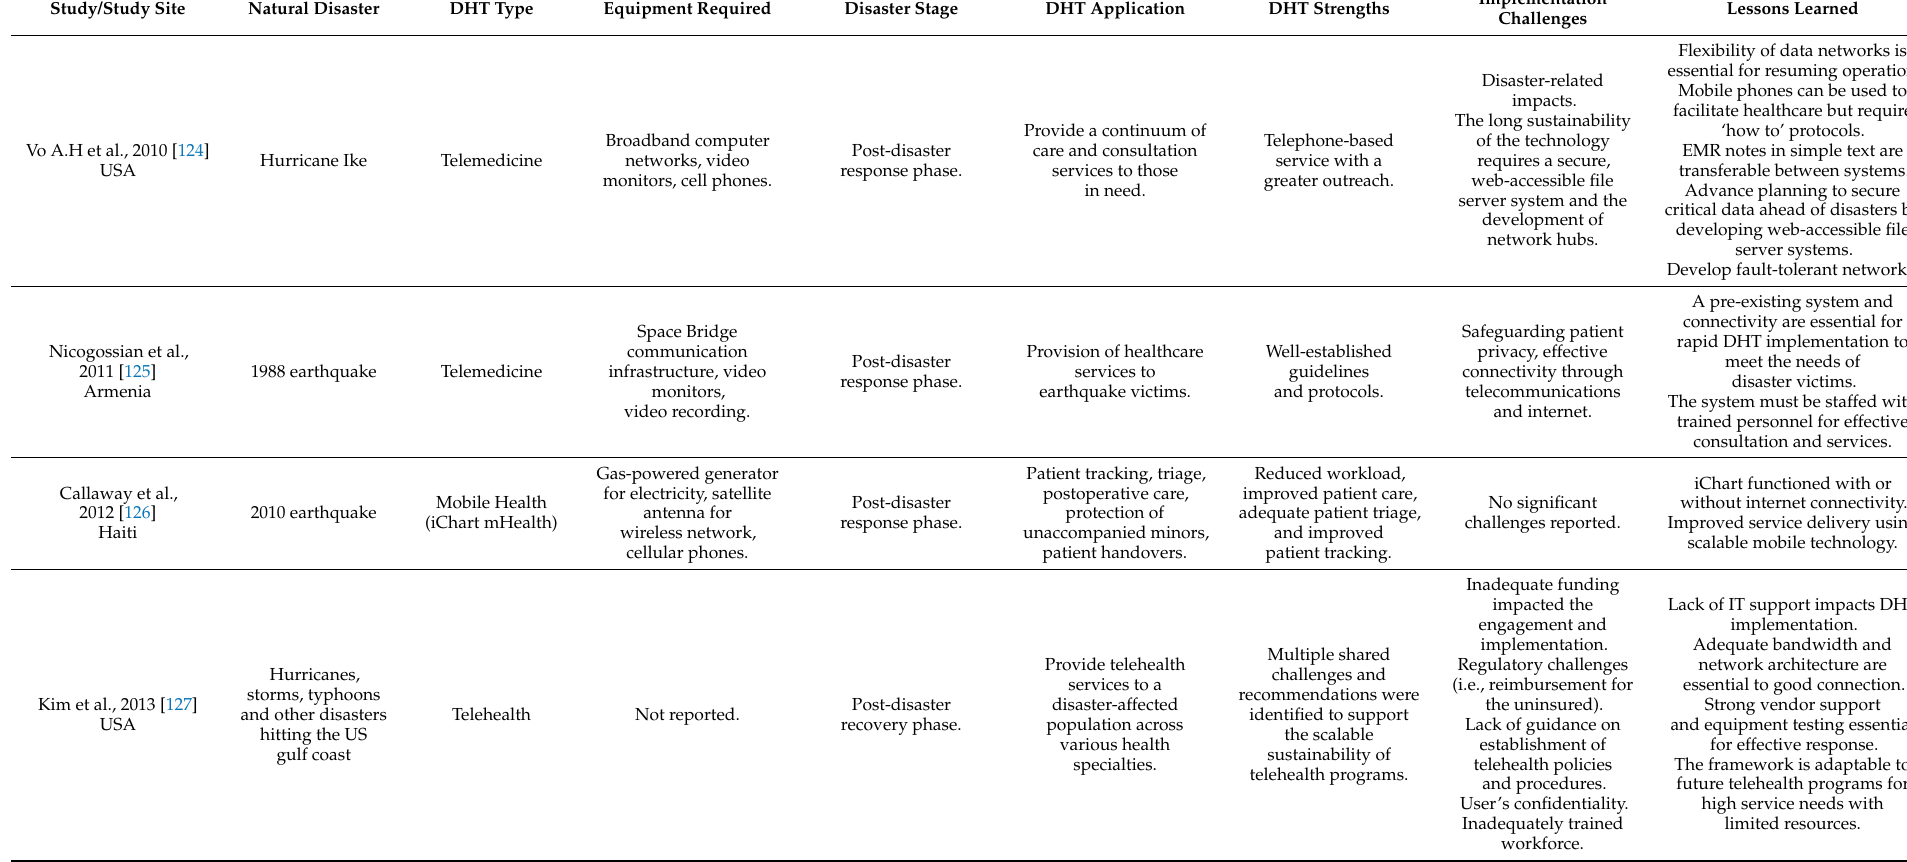
Table 3. Lessons learned from DHT applications to deliver healthcare in major natural disasters across the